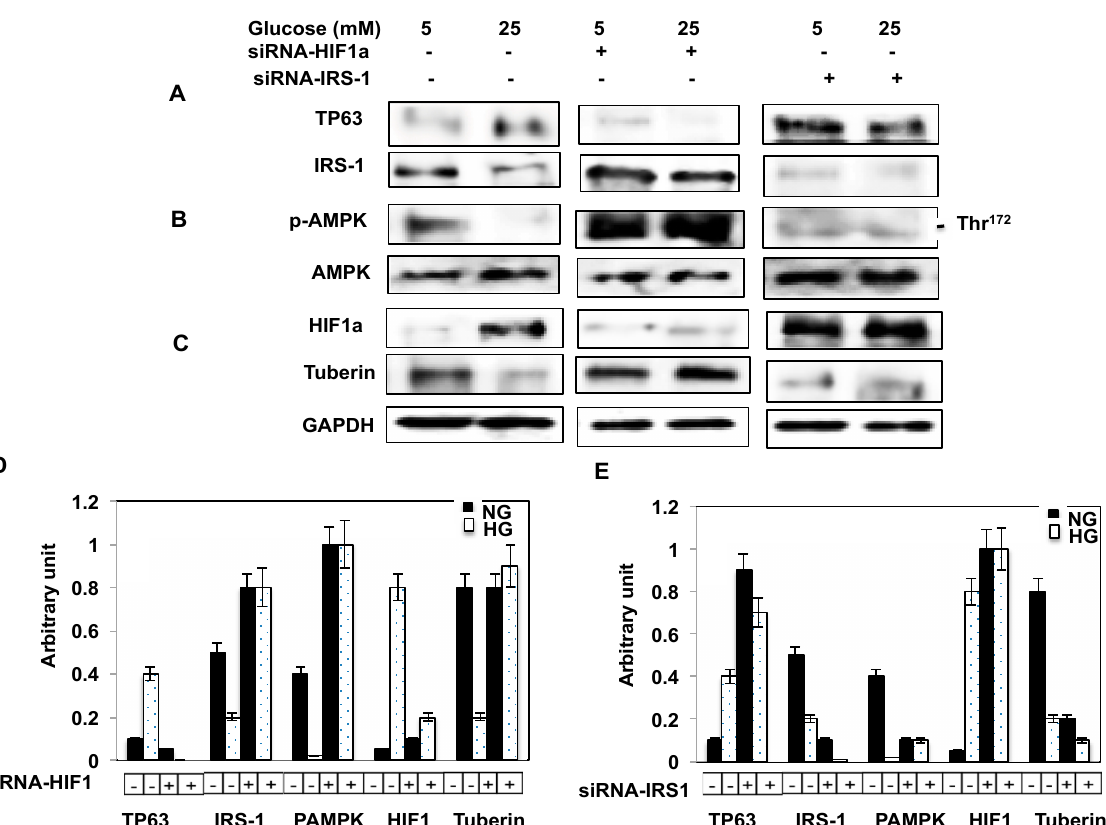
Figure 5. The downregulation of HIF1a and IRS-1 altered TP63 expression in fresh primary proximal tubular renal cells. Primary cells grown in NG or HG condition were infected with siRNA-HIF1a or transfected with siRNA against IRS-1. ( A )The expression of TP63 is significantly decreased with the downregulation of HIF1a and greatly increased with the downregulation of IRS-1. ( B ) The expression of p-AMPK is significantly decreased with the downregulation of IRS-1 and increased with the downregulation of HIF-1a. ( C ) The downregulation of HIF1a increased tuberin expression, while the downregulation of IRS-1 decreased tuberin protein expression. ( D , E ) Histogram of the average expression of each protein presented as an arbitrary unit was calculated from each protein and normalized by GAPDH from 2 Western